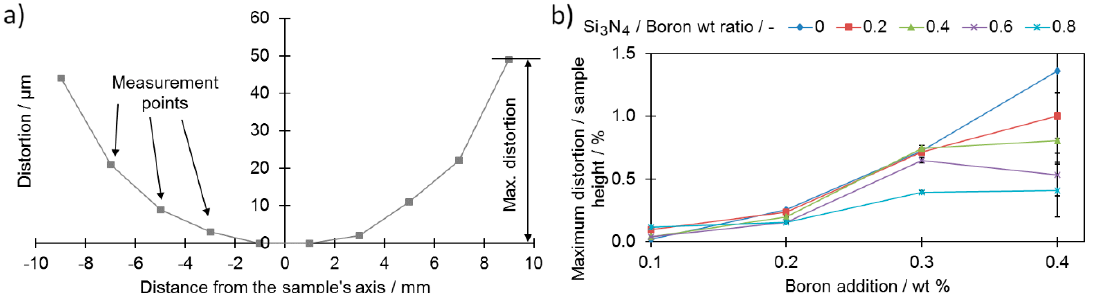
Figure 9. Maximum dimensional distortions of Ø20 × 5 mm cylindrical samples: ( a ) representative example results for sample 4-2; ( b ) as a function of boron and silicon nitride additions. Numerical data are available in Table S4 in the Supplementary Material.